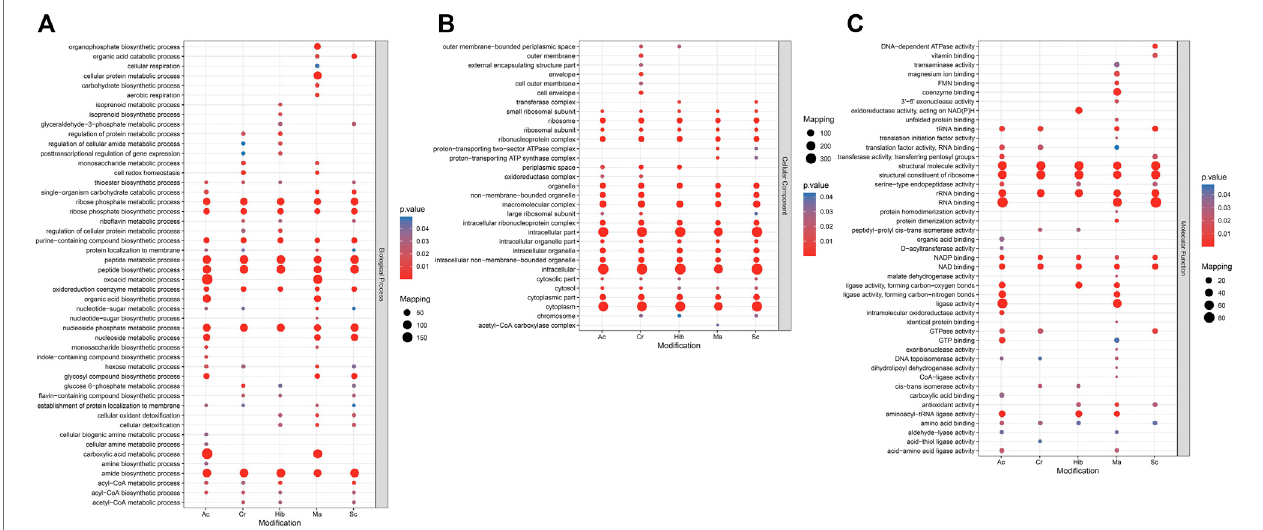
FIGURE 4 | GO (Gene Ontology) enrichment bubble plot of proteins corresponding to modi fi cation sites in three categories [ (A) Biological Process; (B) Cellular Component; (C) Molecular Function]. The GO with a corrected p-value < 0.05 is considered signi fi cant.